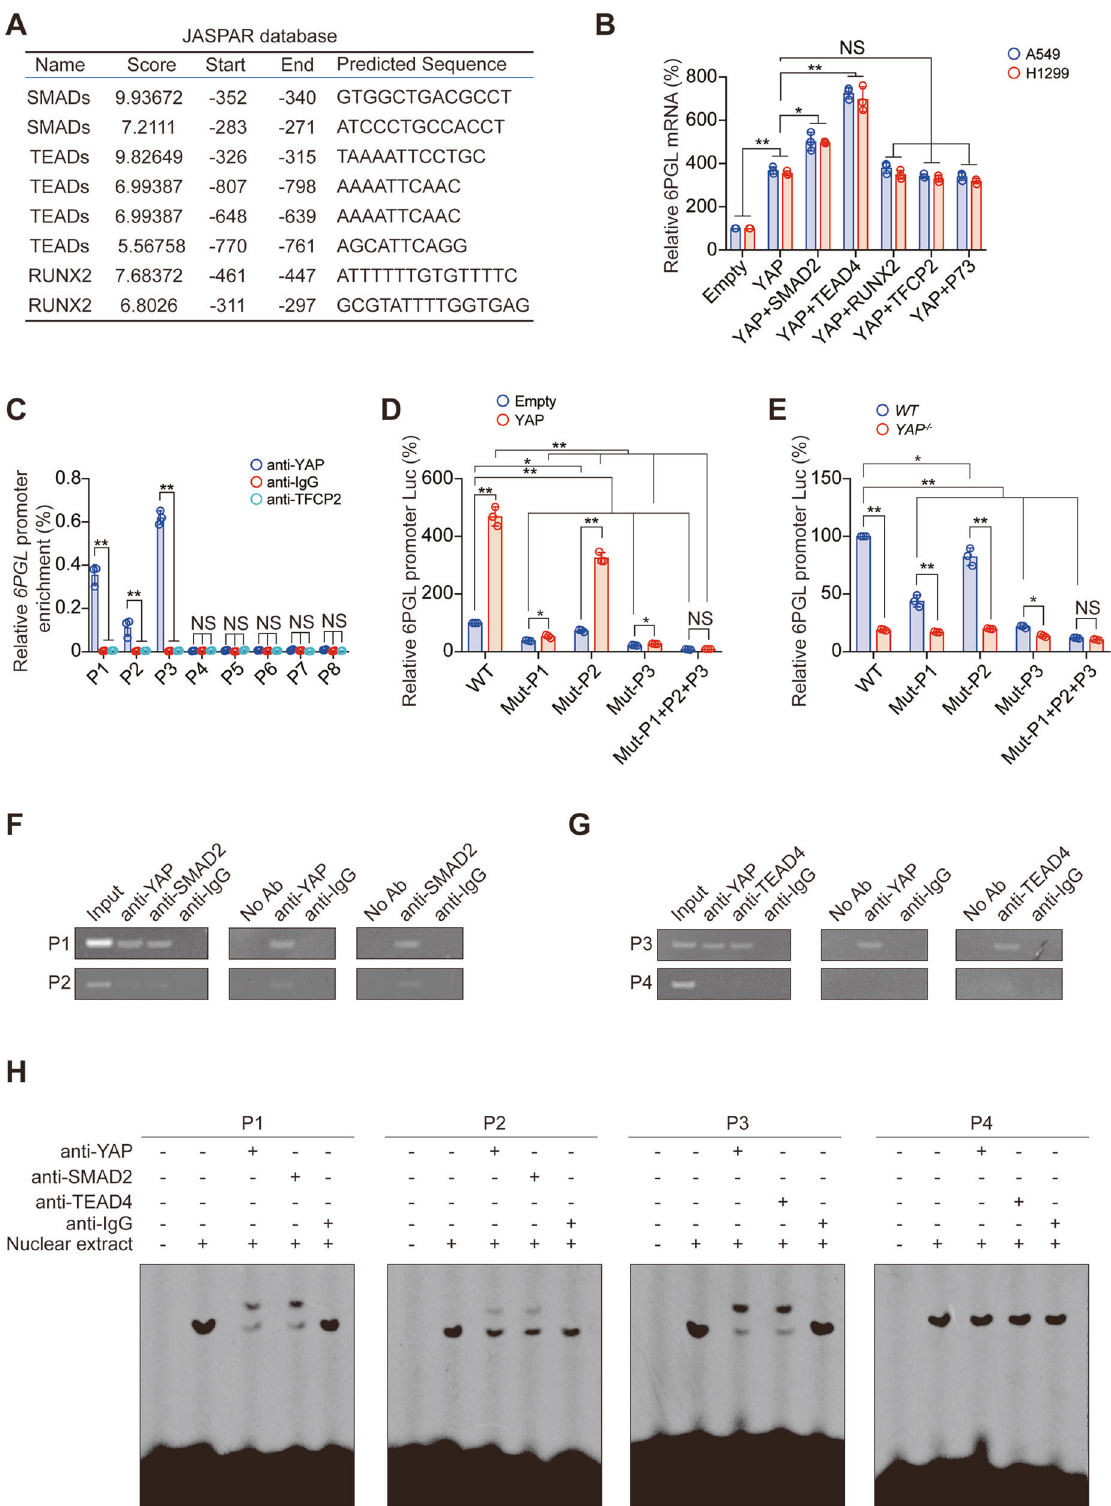
Fig. 5 SMAD and TEAD stimulate 6PGL transcription in a YAP-dependent manner. A Predicting 6PGL promoter binding YAP-associated transcription factors by JASPAR database. B 6PGL mRNA was measured in A549 and H1299 cells with indicated plasmids overexpressed. C The enrichments of YAP at indicated regions of the 6PGL promoter were calculated as the percentage of Input chromosomal DNA via ChIP in A549 cells. Anti-IgG and anti-TFCP2 were used as parallel control. D , E Luciferase activity was analyzed in A549 cells co-expressing indicated 6PGL promoter – reporter with or without overexpressing ( D ) or knocking out YAP ( E ). F , G Co-occupancies of YAP and SMAD2 ( F ) and YAP and TEAD4 ( G ) were measured by ChIP and Re-ChIP experiments in A549 cells using indicated antibodies. H Nuclear extracts from A549 cells were incubated with indicated 6PGL promoter probes with or without the presence of indicated antibodies. The DNA – protein interactions were measured using EMSA. The data are shown as the mean ± SD from three biological replicates (including IB). Data in B – E were analyzed using a one-way ANOVA test. ** P < 0.01, * P < 0.05, NS nonsigni fi cant. Cell Death Discovery (2022)